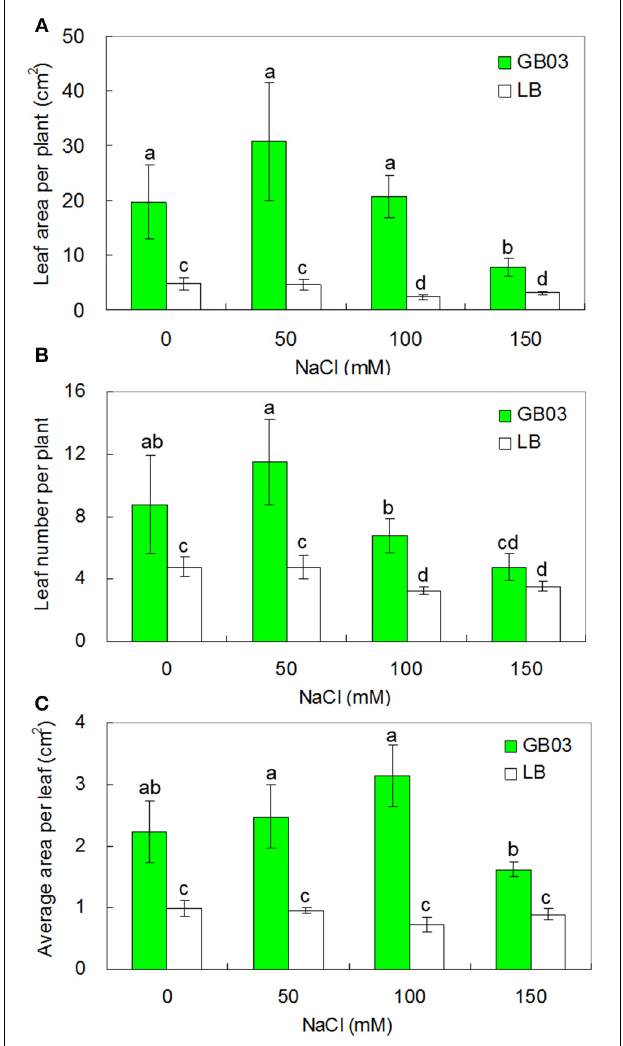
FIGURE 3 | Effects of GB03 bacterization on leaf development and growth of white clover under various concentrations of NaCl. (A) leaf area per plant, (B) leaf number per plant, and (C) average area per leaf. Values are means and bars indicate SDs ( n = 8). Columns with different letters indicate significant difference at P < 0 . 05 (Duncan